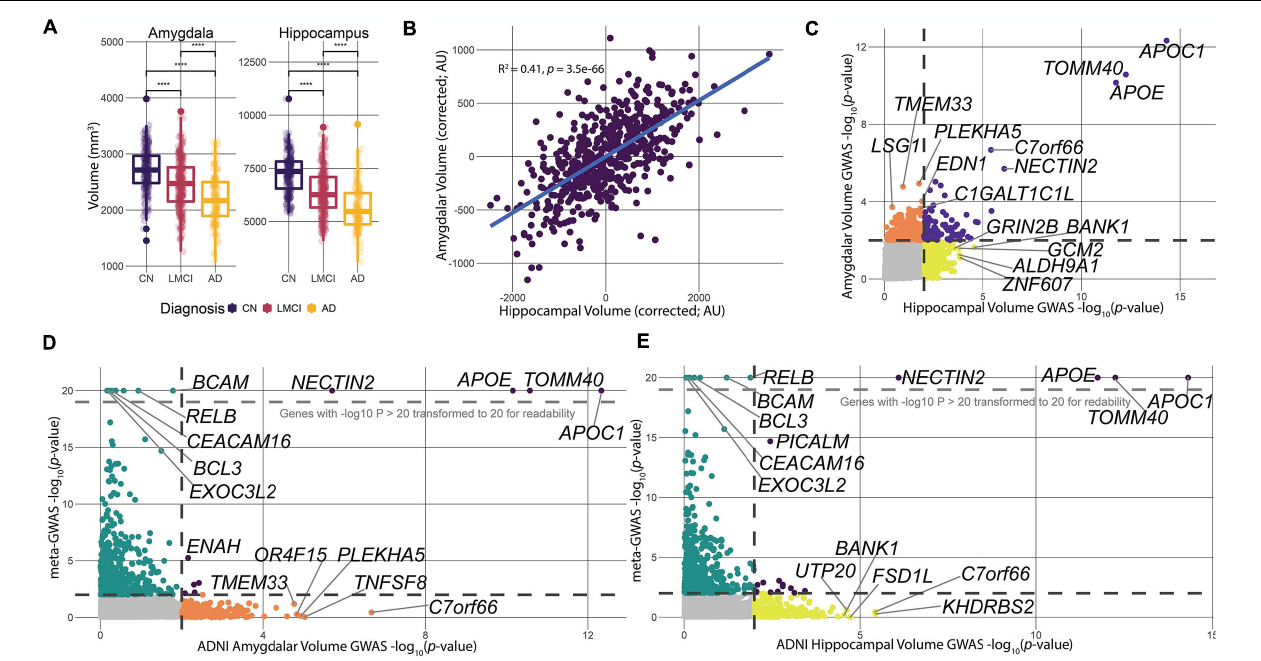
FIGURE 2 | Data processing and comparison of hippocampal and amygdalar volume GWAS and meta-GWAS summary statistics. (A) We calculated the correlation between each of the three clinical diagnoses for ADNI-1 and the respective tissue volume measures. All three diagnoses showed significant ( p < 2e-16) differences in average volume size across tissues. (B) Linear models predicting HV and AV were calculated to determine the correlation in size of the two structures. There was a significant, moderate correlation ( R 2 = 0.41, p = 3.6e-66) between the volumes of the two structures controlling for diagnosis at baseline, education, sex, ICV, and age. (C) Comparison of p -value distributions for the two GWAS volume measures. Dotted lines indicate a nominal significance cutoff of 0.01. (D,E) Comparison of p -value distributions between the meta-GWAS data and the respective volume GWAS data. Genes with log transformed p -values greater than 20 were transformed to 20. Black dotted lines indicate a nominal significance cutoff of